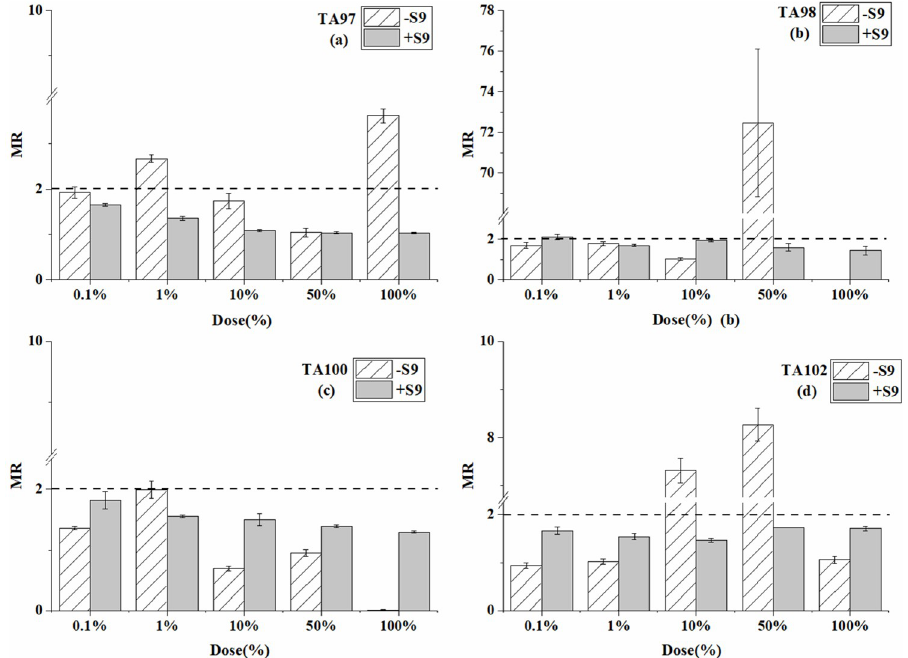
Fig 4. Mutagenesis of mixtures of BP-6 and 4-MBC to four strains in the presence and absence of S9 liver extract; (a) TA97 strain; (b) TA98 strain; (c) TA100 strain; (d) TA102 strain. The mutation ratio (MR) is the average ratio ( ± SE) from three parallel